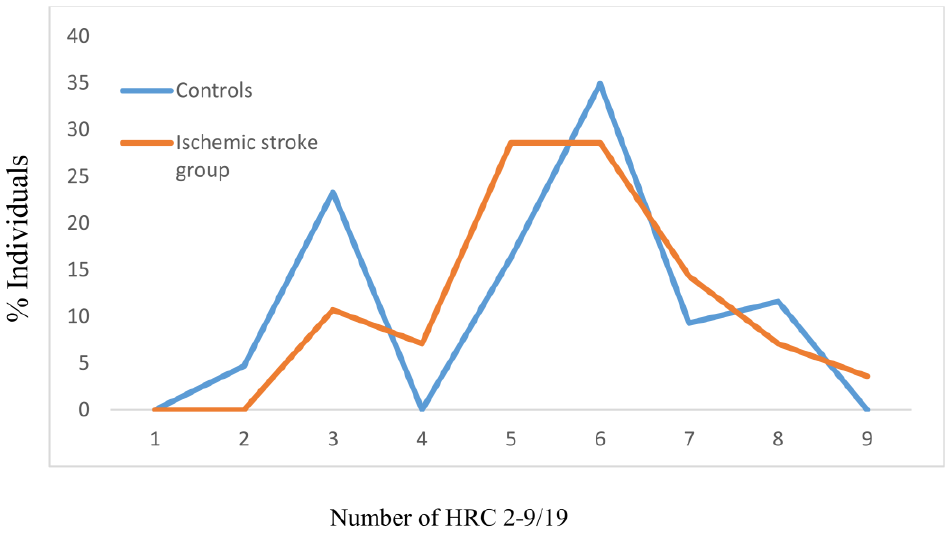
Figure 3. Frequencies of homozygous recessive characteristics (HRC) in controls and manifested ischemic stroke patients with hypertension. MV- mean value; SD- standard deviation; z - Mann Whitney U test; V- variability. Controls: N = 86, MV ± SD = 5.28 ± 1.75. Ischemic stroke group: N = 56, MV ± SD = 5.64 ± 1.48 ( z = −0.783, p = 0.435; Cohen’s d = 22.21%). V Controls = 33.14%, V Ischemic stroke group = 26.24%. Table 3. Statistical evaluation of frequencies of homozygous recessive characteristics between groups with regards to the presence of hypertension.